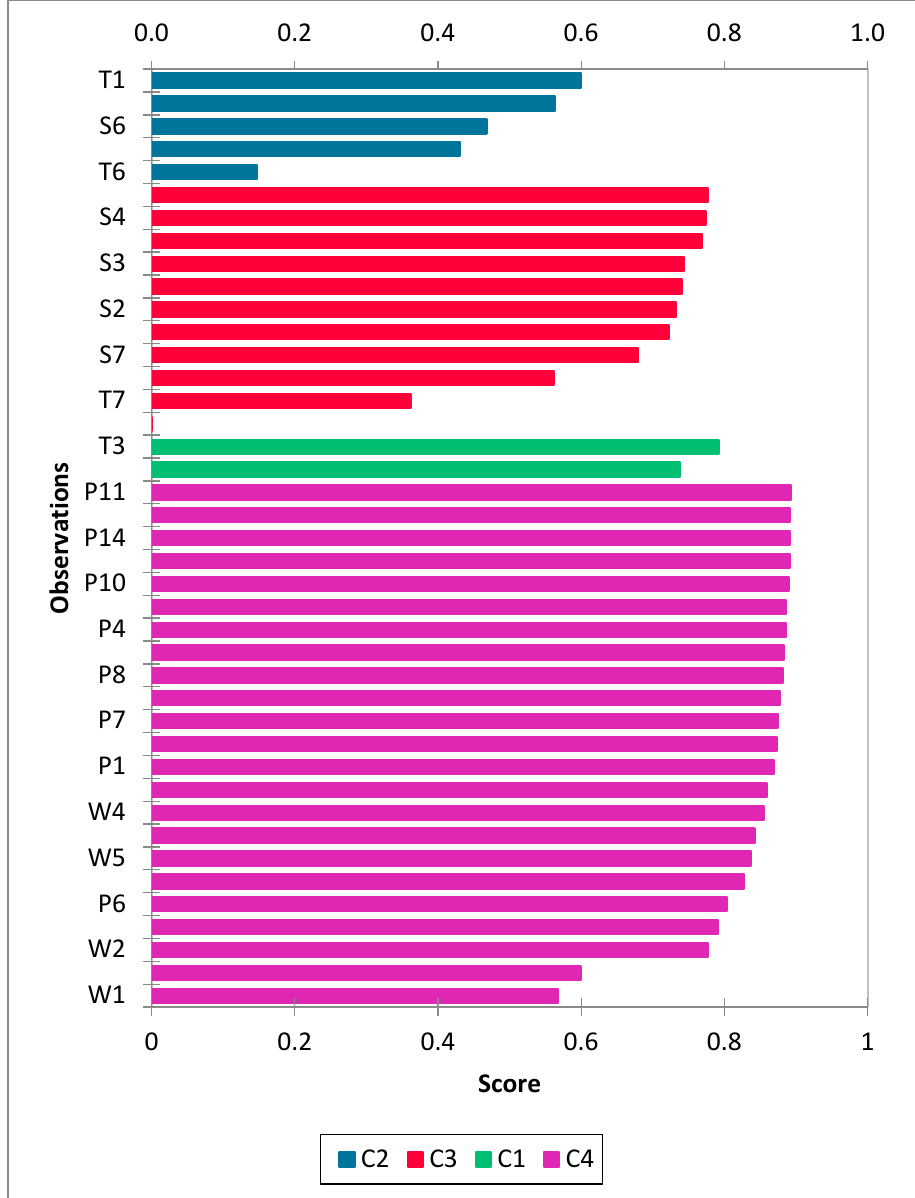
Figure 5. K-mean cluster plot showing silhoue tt e scores for each observation.